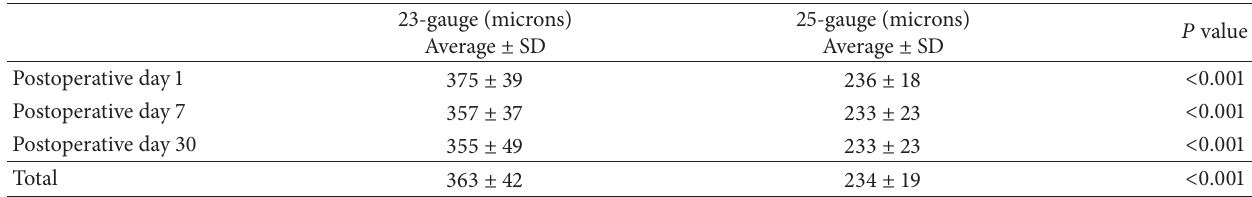
Table 2: Longitudinal length of sclerotomy incisions after transconjunctival sutureless pars plana vitrectomy performed with 23-gauge and 25-gauge measured with SD-OCT at the postoperative